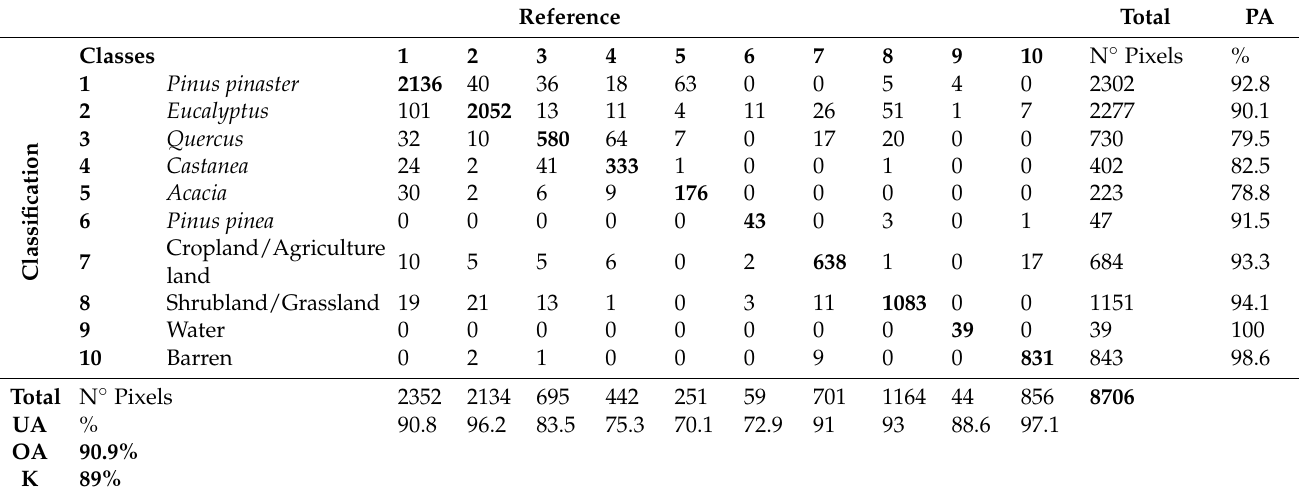
Table 4. Confusion matrix and statistical measures for RF vegetation